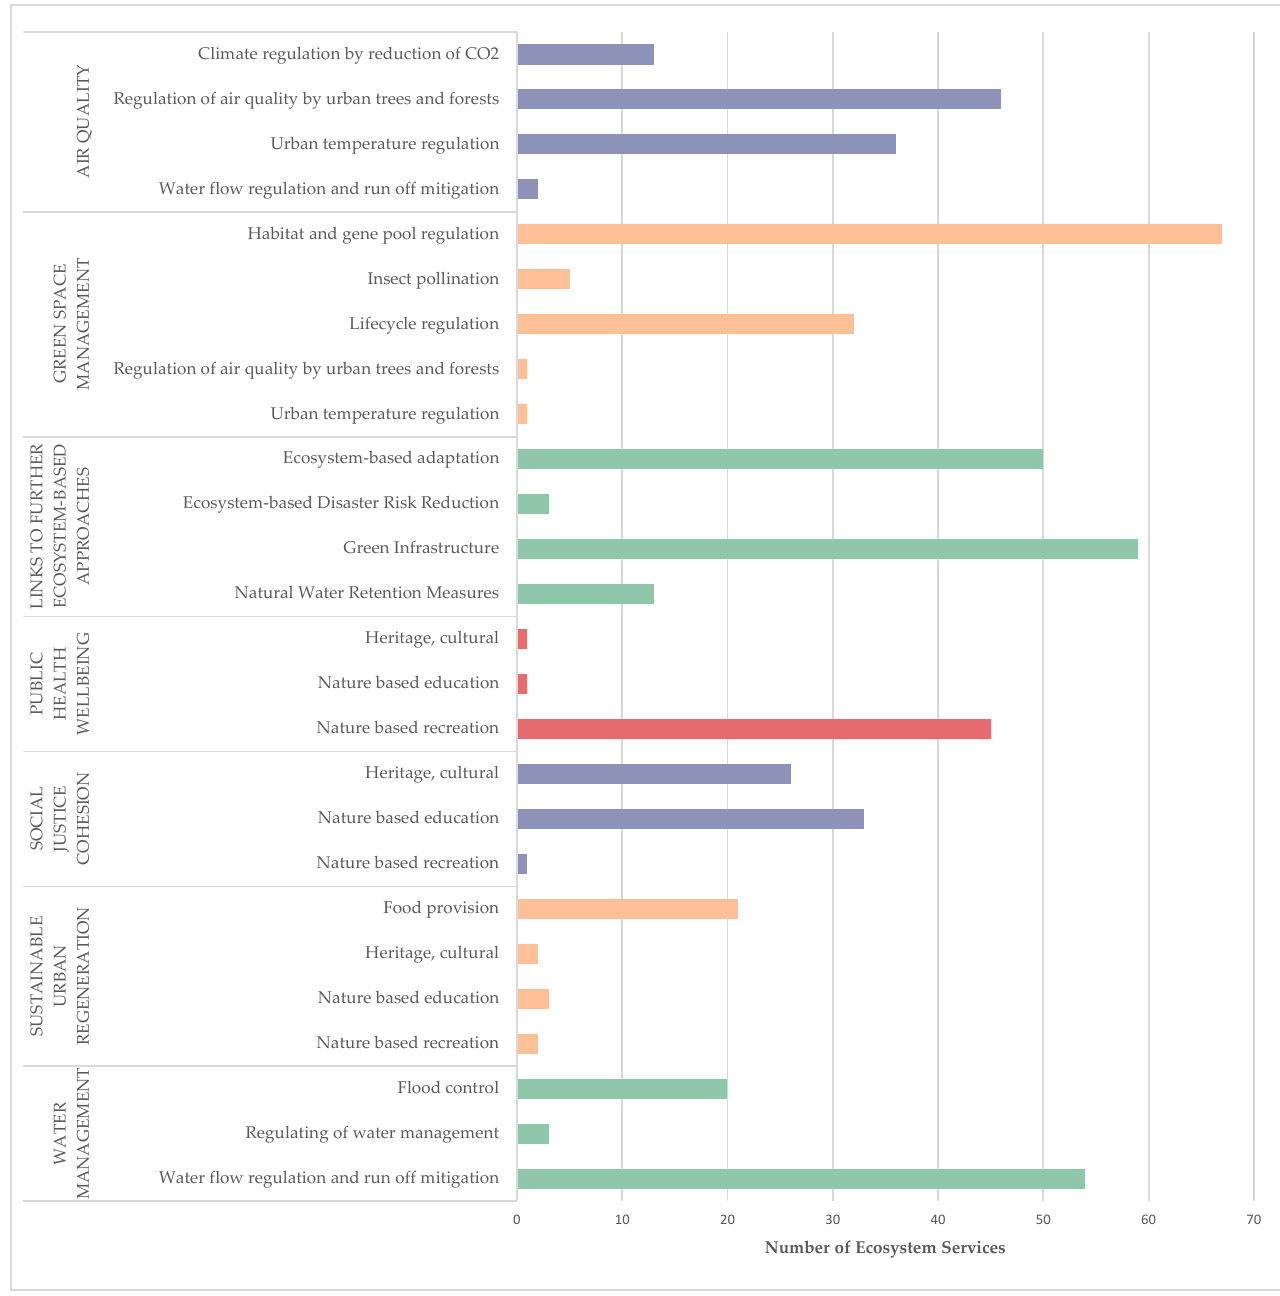
Figure 9. NbS ecosystem services.